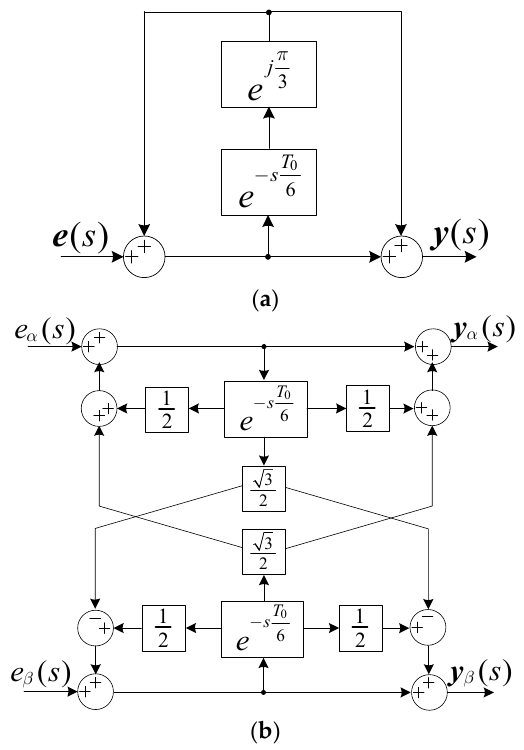
Figure 3. Block diagram of the 6 k + 1 repetitive controller internal model: ( a ) Complex ‐ vector notation; ( b ) Scalar notation.